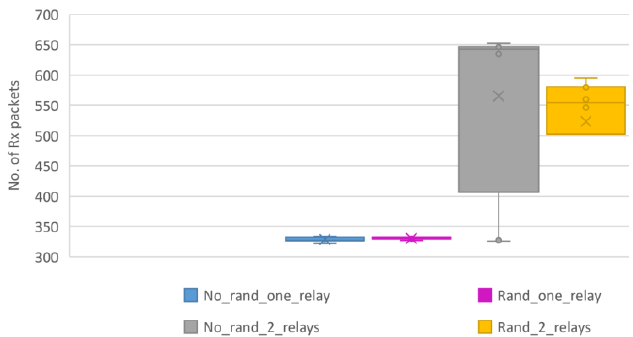
Figure 18. Effect of channel randomization on packet reception in a dense network